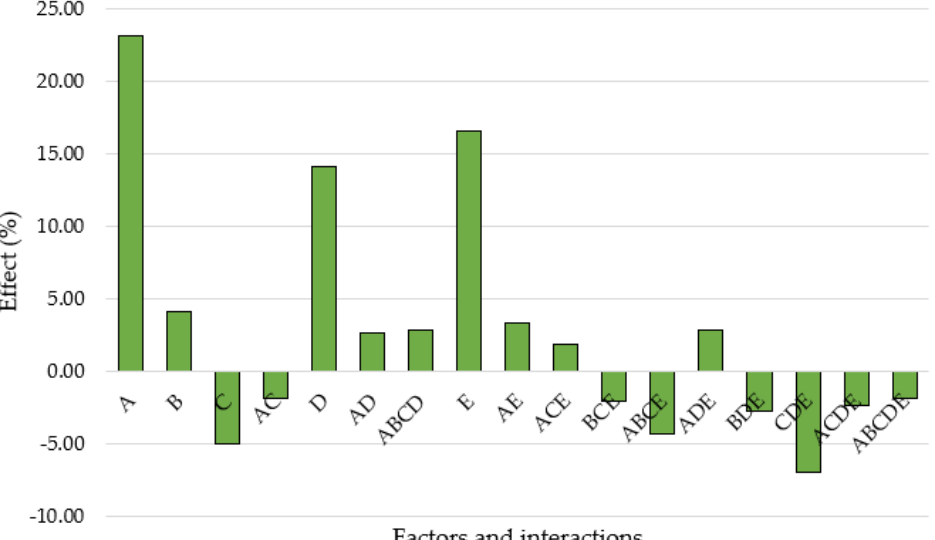
Figure 6. Main factors and their interaction effects on Pd leaching.